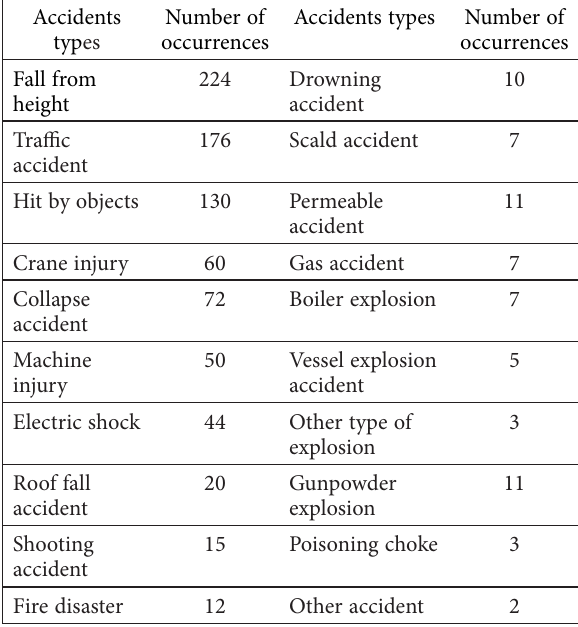
Table 6. The statistics of different accident types